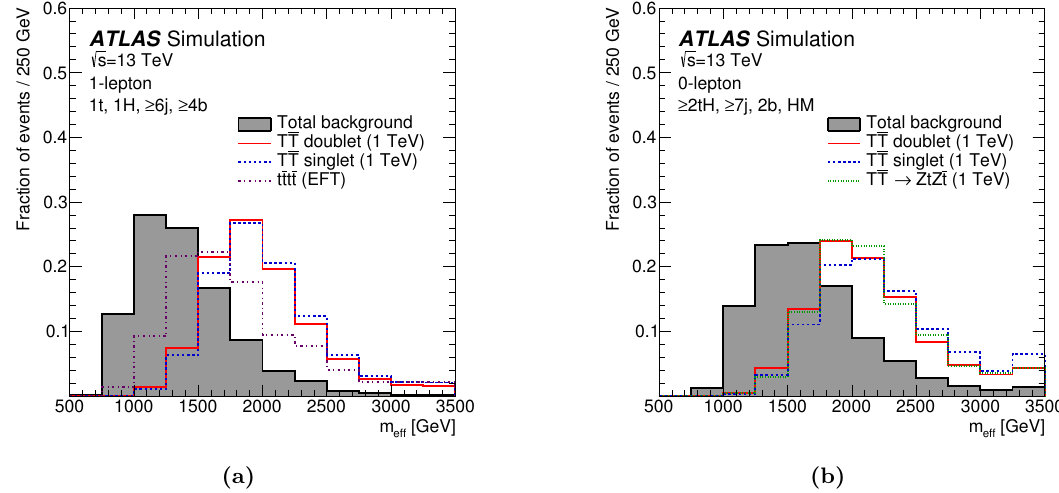
Figure 5. Comparison of the distribution of the e(cid:11)ective mass ( m e(cid:11) ), between the total background (shaded histogram) and several signal scenarios considered in this search. The selection used in (a) corresponds to events in the (1t, 1H, 6j, 4b) region of the 1-lepton channel, whereas the selection (cid:21) (cid:21) used in (b) corresponds to events in the ( 2tH, 7j, 2b, HM) region of the 0-lepton channel. The (cid:21) (cid:21) signals shown correspond to: T (cid:22) T production in the weak-isospin doublet and singlet scenarios, and in the ( T Zt ) = 1 case, assuming m T = 1 TeV; and t (cid:22) tt (cid:22) t production within an EFT model. The B ! last bin in each distribution contains the